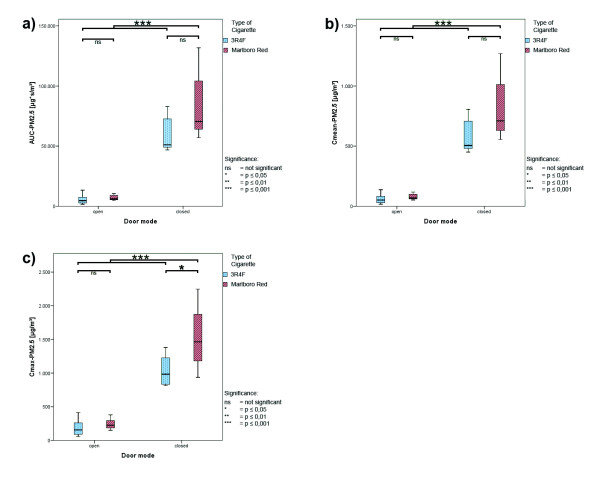
Boxplots of ETS exposure; total measurement interval. a) AUC-PM2.5; b) Cmean-PM2.5; c) Cmax-PM2.5-concentration for 3R4F and Marlboro Red cigarettes;data were analyzed under open- and closed-door conditions.